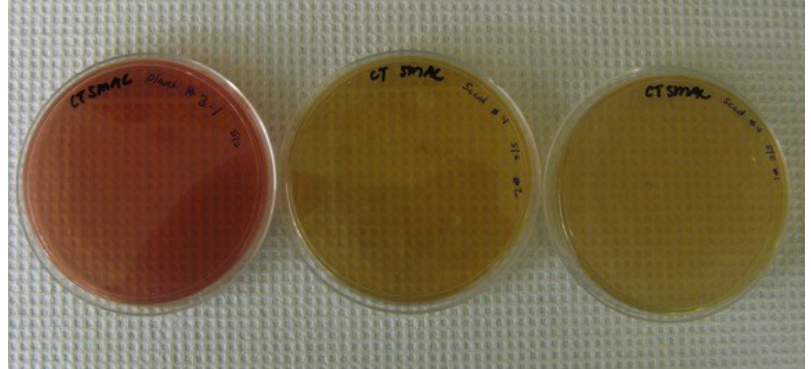
Figure 6. CT-SMAC plates from E. coli O157:H7-GFP samples recovered from tomatoes that had been seed contaminated with the bacterium (two plates on the right) and were positive for GFP following PCR. E. coli O157:H7 does not ferment sorbitol and appears as white colonies on CT-SMAC plates. As a negative control, cultures were plated that were not positive for GFP. The plate on the left is representative of the plates obtained with colonies all appearing red in color (can ferment sorbitol) indicating that they are not E. coli